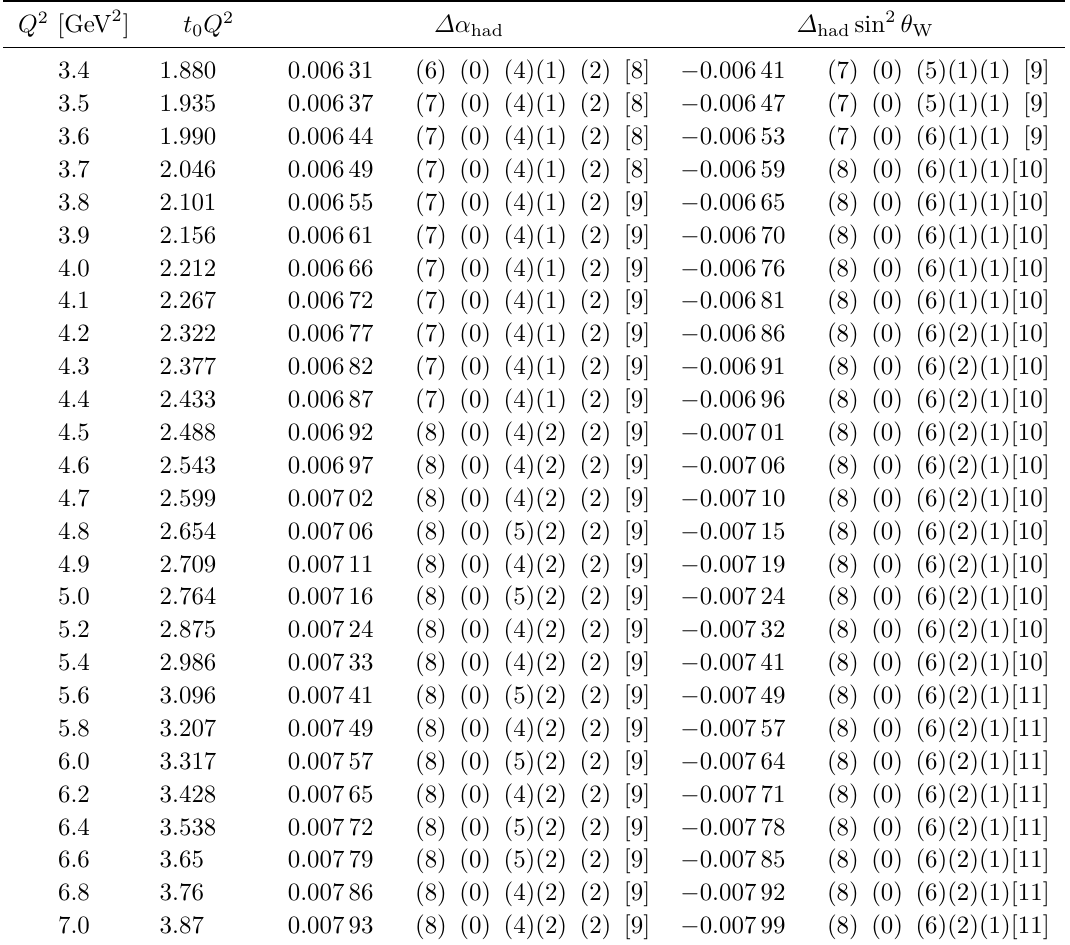
Table 13 . Results for the total HVP contribution to the running of α and sin 2 θ W extrapolated to the physical point for all the values of Q 2 sampled. Following the statistical error, and the systematic errors from varying the fit model estimated, scale-setting and missing charm sea-quark loops, the fifth uncertainty is the systematic error from missing isospin-breaking effects (see section 4.2.3). The final uncertainty, quoted in square brackets, is the combination of the previous